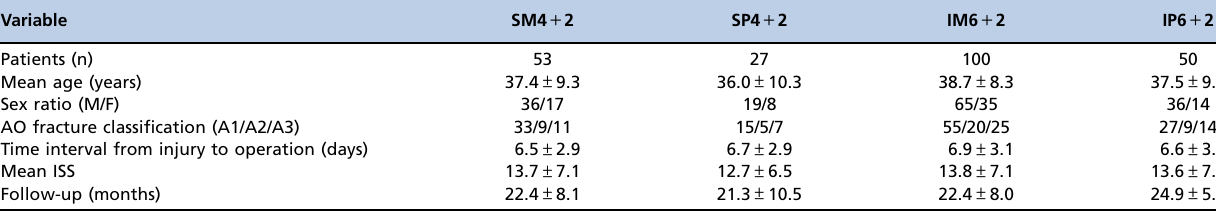
Table 1 - Preoperative demographic and clinical data [Mean ±